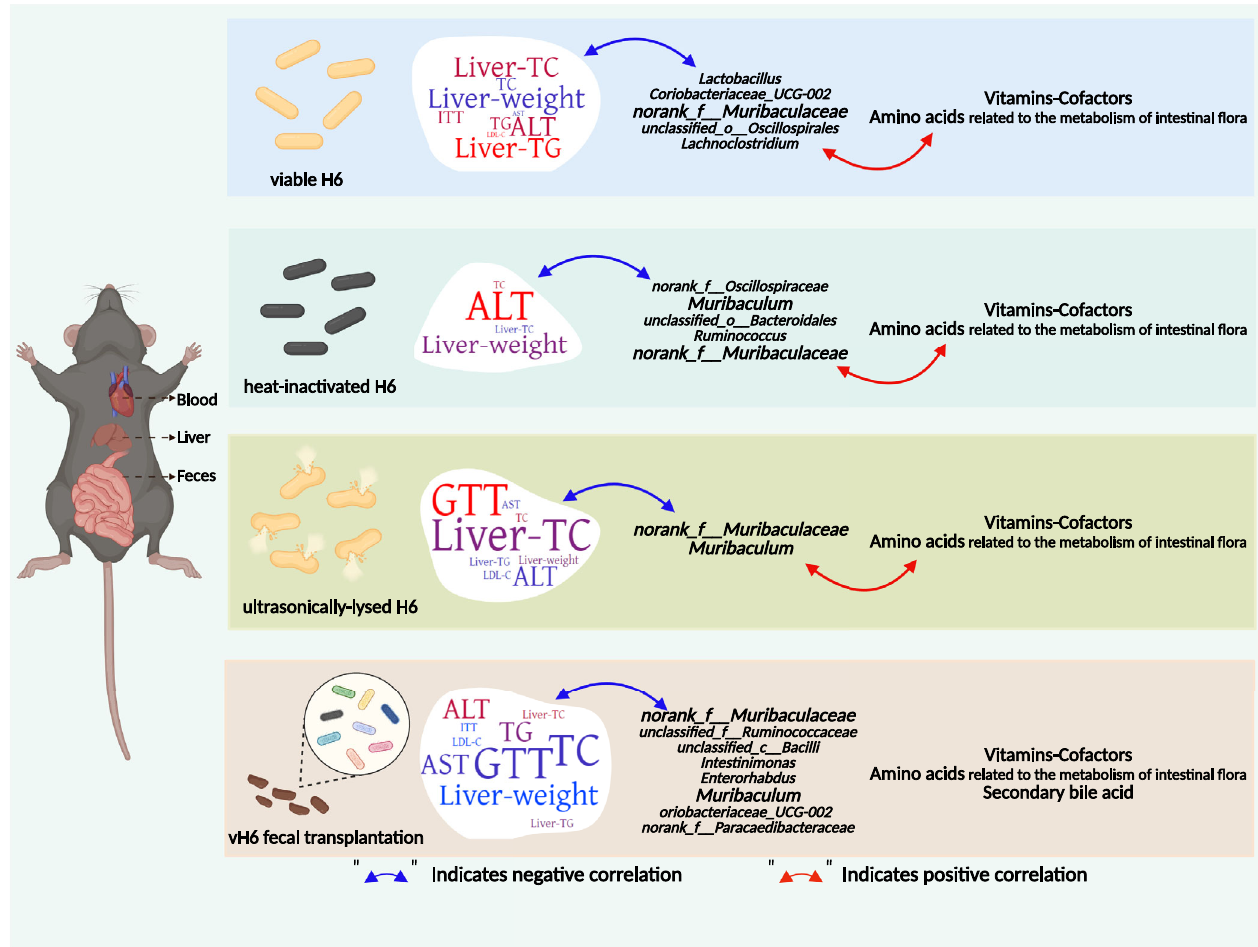
Fig. 7 Schematic illustration of outlining the hypocholesterolemic effect of L.p H6 by regulating the intestinal microbiota and microbial metabolites related to lipid metabolism. v/i/uH6 cells could lower TC, TG, LDL-C, ALT, AST in the serum, and TC, TG in the liver at various levels, and improve GTT and ITT indexes. Also, the recovery of these biochemical indices and gut microbiome was found following FMT using stool from vH6 treated mice. Muribaculaceae was found to be the most abundant in the intestine of mice after v/i/uH6 treatments, suggesting that it could be used as a potential biomarker for effectively lowering cholesterol. The v/i/uH6 cells increased the intestinal fl ora metabolism of vitamins-cofactors, as well as amino acids, while decreasing the relative content of primary bile acids. The Pearson correlation analysis showed that norank_f__Muribaculaceae and Lactobacillus had a negative correlation with blood lipid levels. RDA indicated a strong positive correlation between the production and abundance of fecal metabolites and intestinal microbes in hypercholesterolemic mice given v/i/uH6. Overall, v/i/ uH6 cells were effective in improving hypercholesterolemia in mice, and this effect was attributed partly to the regulation of intestinal microbiota and metabolites related to lipid metabolism. v/i/uH6 refers to viable (vH6), heat-inactivated (iH6), and ultrasonically-lysed (uH6) bacteria cells. (Figure was created with